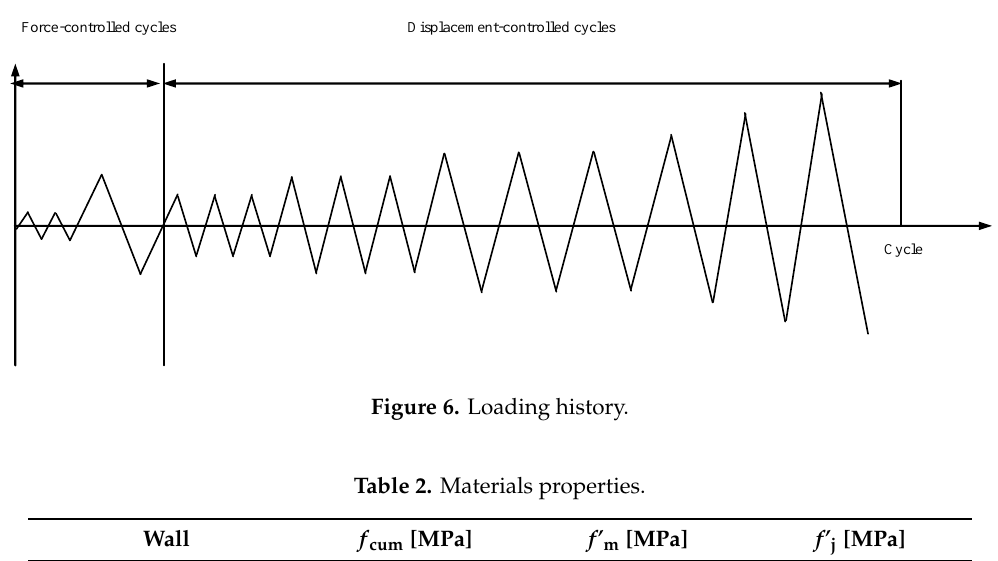
Table 2. Materials